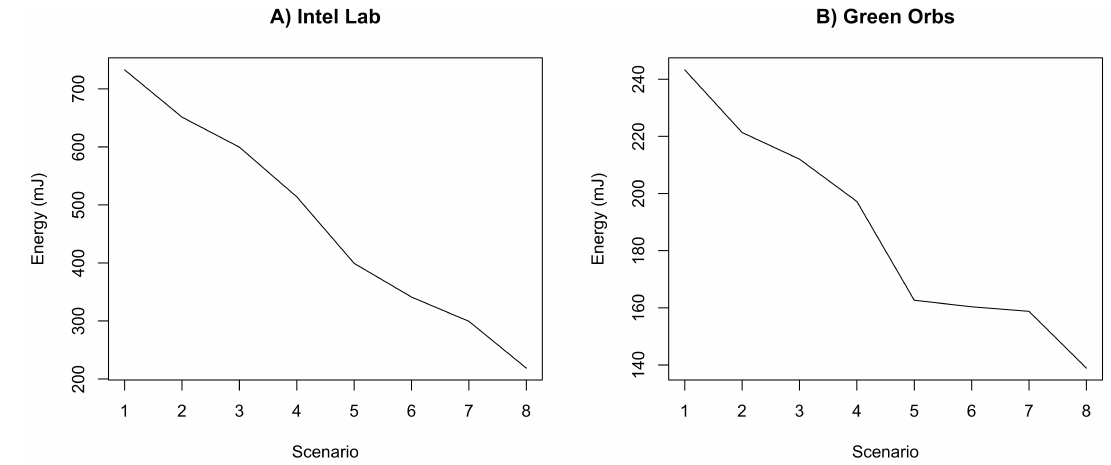
Figure 10. Energy consumption of ACxSIMv2 in the simulated scenarios for Intel Lab and Green Orbs